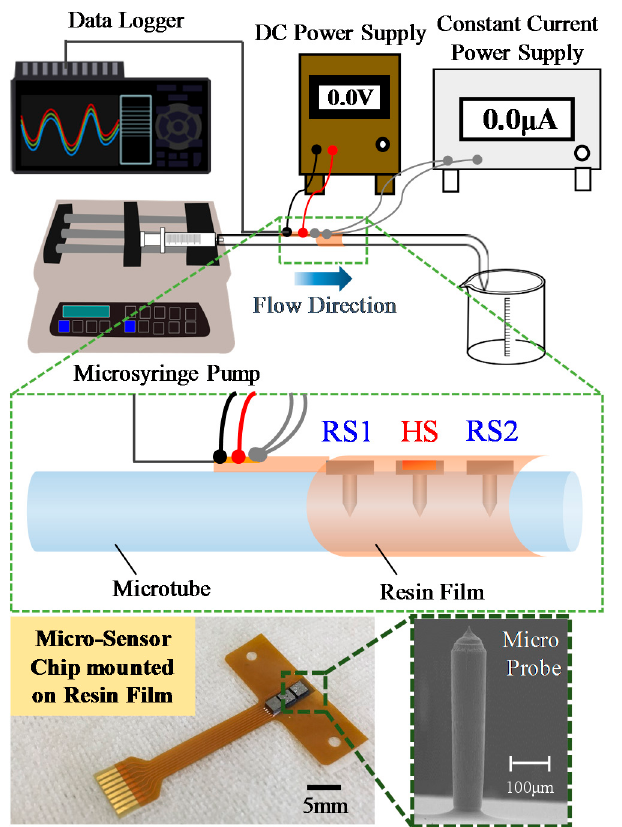
Figure 7. Mimicked plant experimental setup.